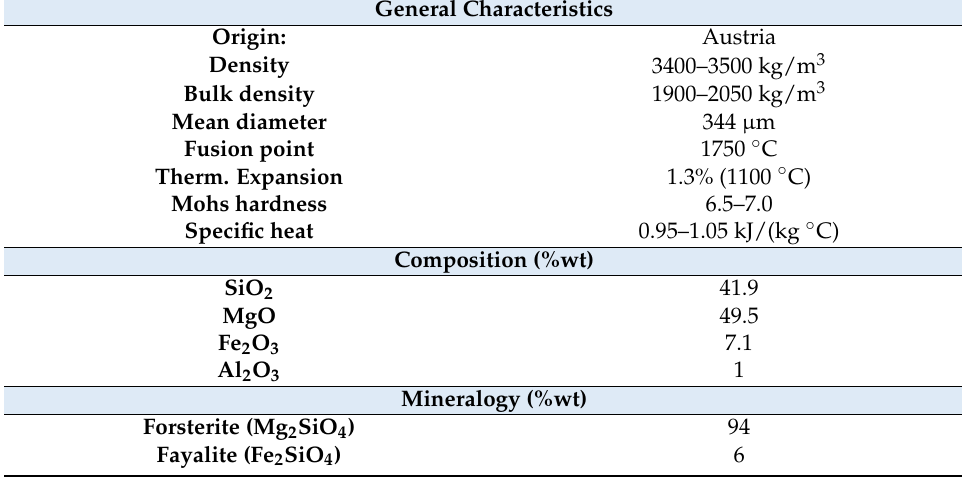
Table 2. Relevant characteristics of Magnolithe GmbH